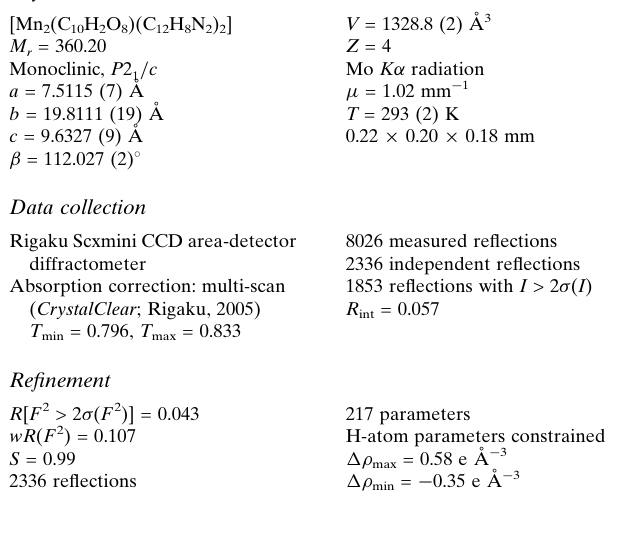
Rigaku Scxmini CCD area-detector diffractometer